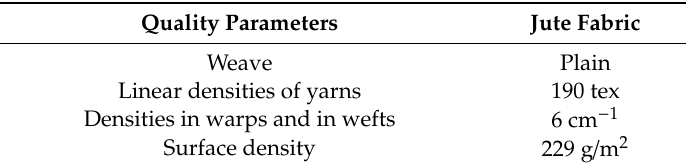
Table 1. Specification of jute